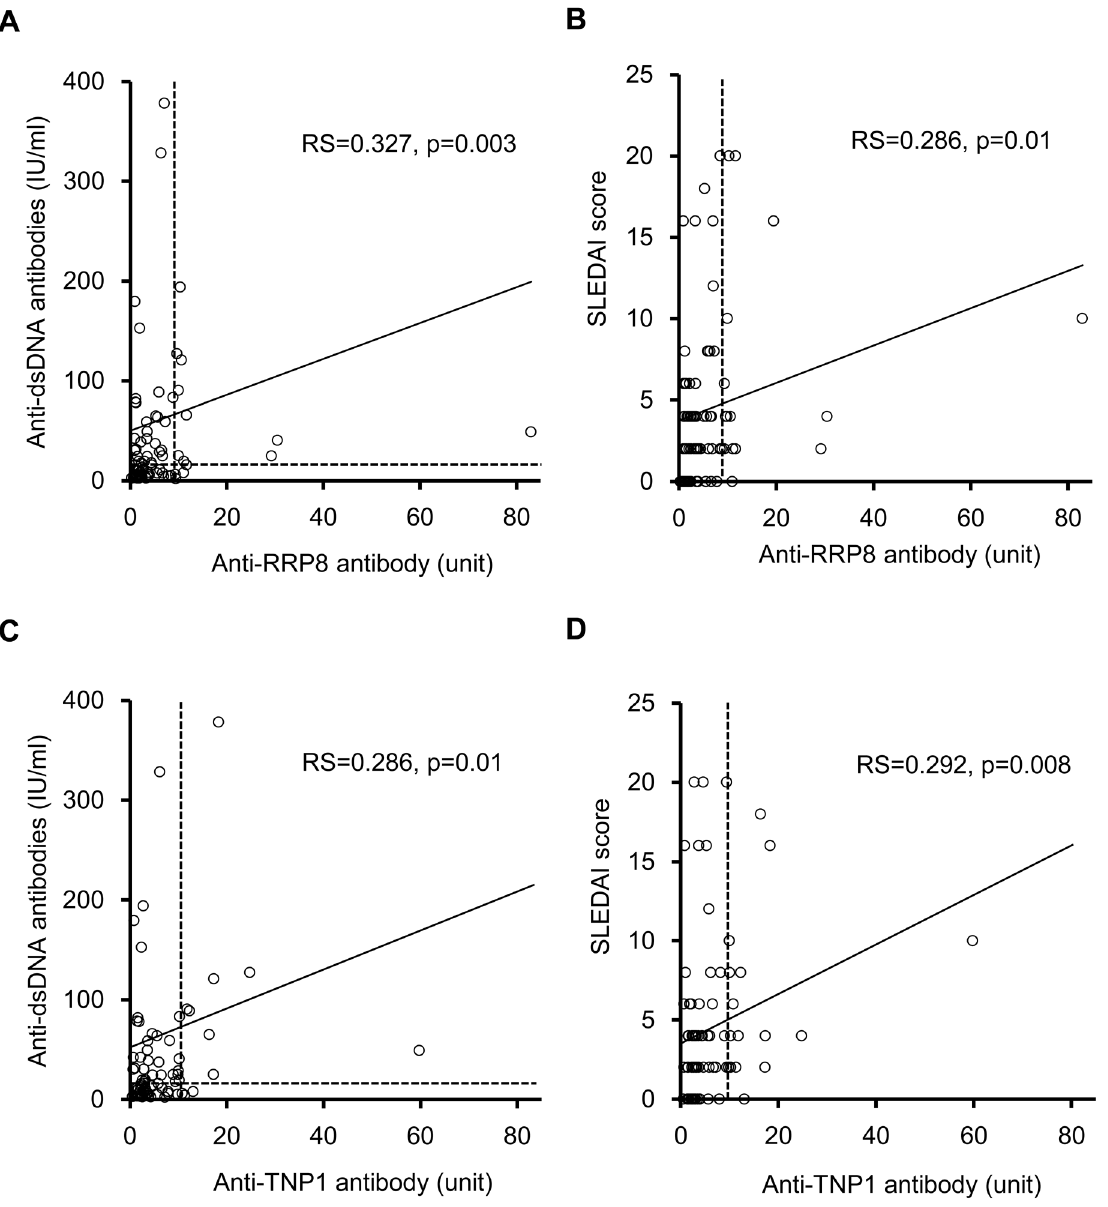
Fig 4. Relationship between anti-RRP8 or anti-TNP1 antibody and clinical findings in SLE patients. (A) anti-RRP8 antibody and anti-dsDNA antibodies, (B) Anti-RRP8 antibody and SLEDAI, (C) anti-TNP1 antibody and anti-dsDNA antibodies, (D) anti-TNP1 antibody and SLEDAI. SLEDAI, systemic lupus erythematosus disease activity index. Correlations were expressed as Spearman rank correlation coefficients. P values of < 0.05 were considered